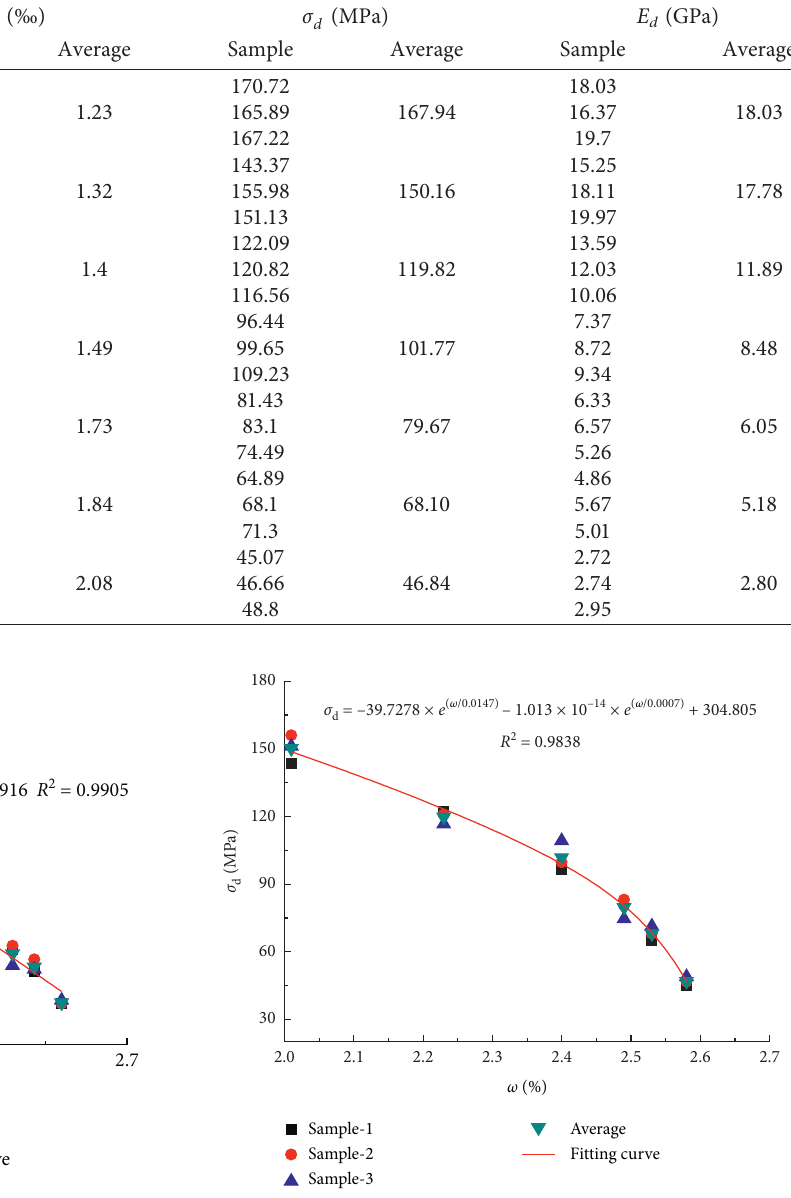
Figure 9: Dependence of peak strength on moisture